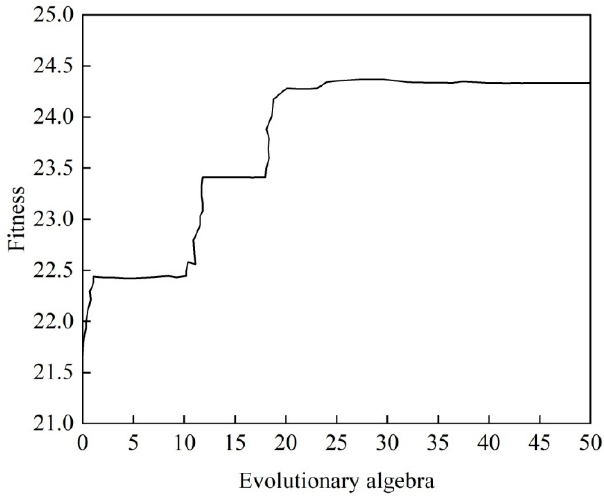
Figure 11. Theprocess of optimization. Table 10. Comparison of results before and after collaborative optimization.